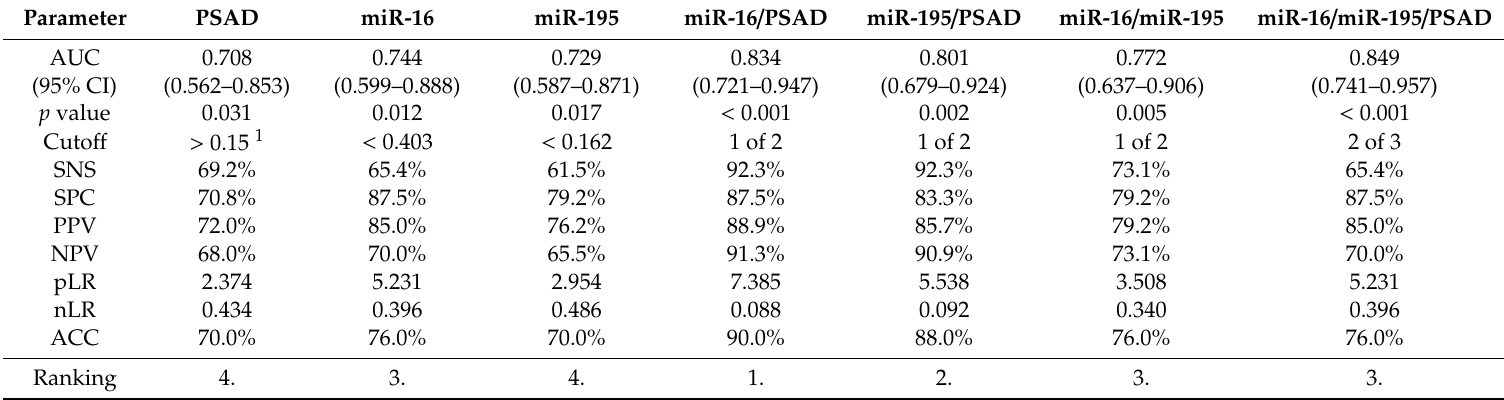
Table 3. Comparison of the diagnostic power of PSAD as well as of miR-16 and miR-195 expression levels in urinary sediments individually and in various combinations using the whole study cohort ( n =